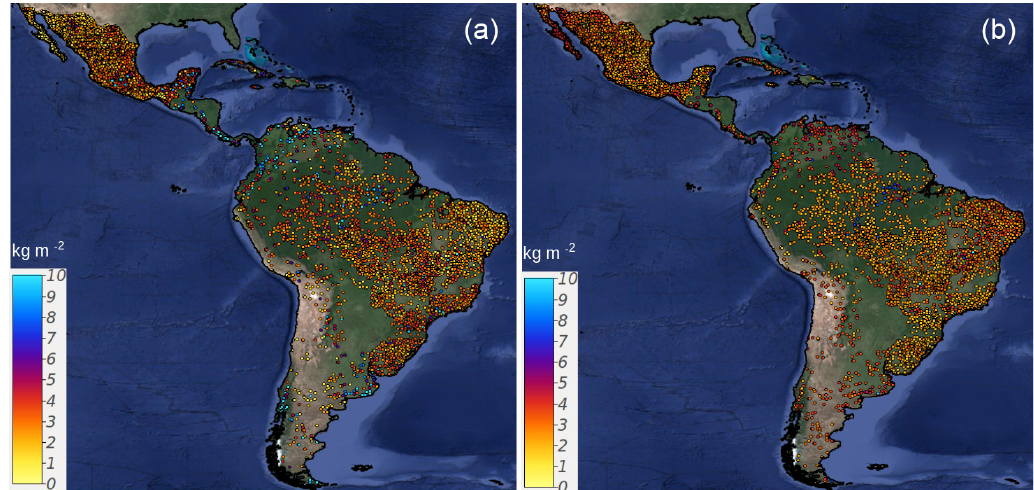
Figure 2. Spatial distribution of available SOC in WoSIS for Latin America. SOC estimates are calculated for each point using Eq. (2) (a) . The approximated error is based on Taylor series as implemented in the R-GSIF package, as is explained in Heuvelink (2018) (b) . Thus, panel (b) represents the uncertainty of SOC estimates at each point. The values of this map could be associated with data limitations and missing information for BLD and